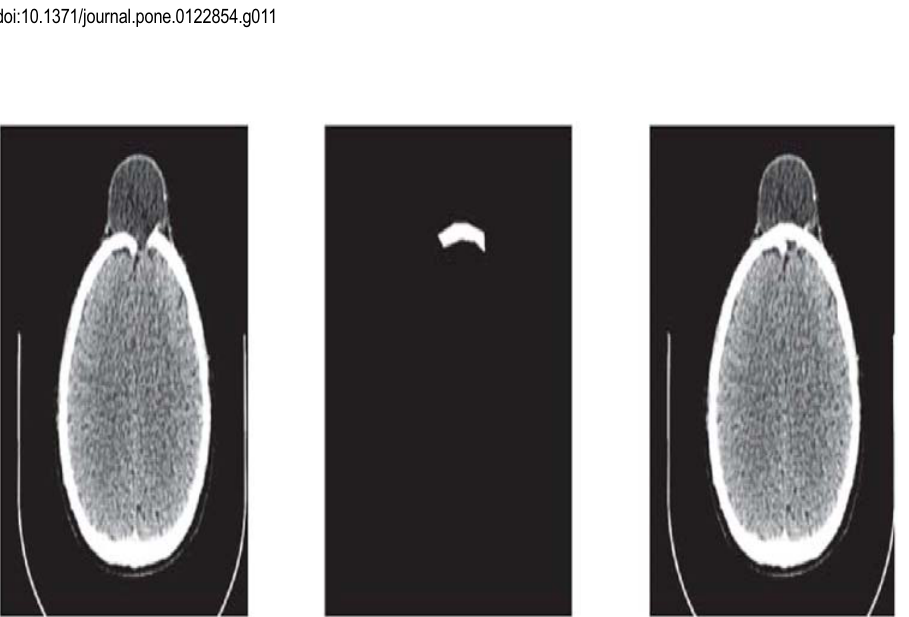
Fig 11. CT scanned data of slice 171. (a)Original image (b) Binary image (c) Boundary (d)Reconstructed missing part using rational cubic Ball